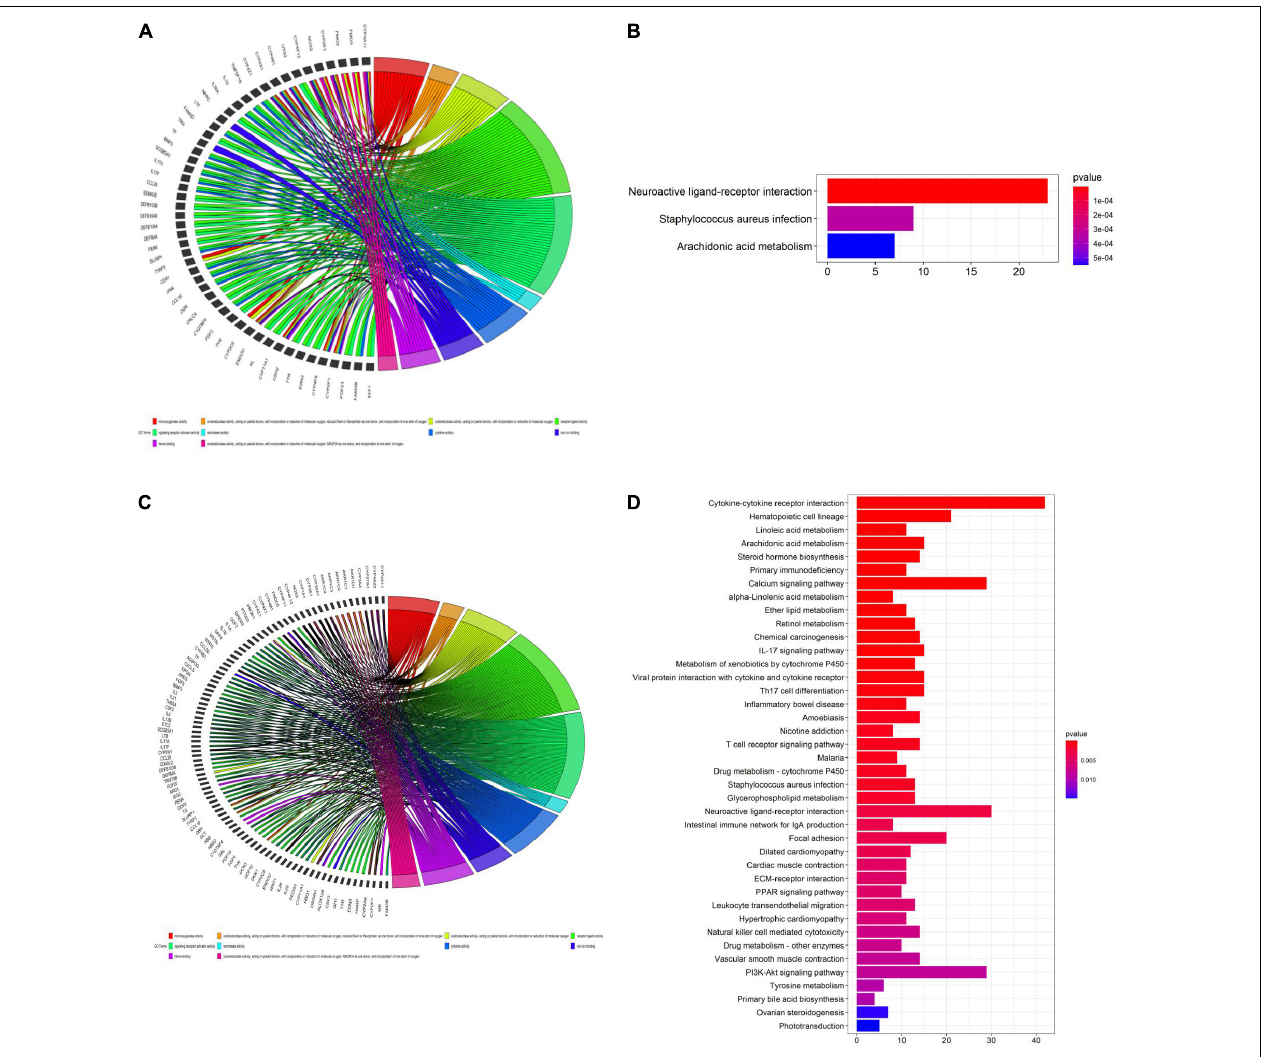
FIGURE 8 | Gene ontology (GO) (A,C) and Kyoto encyclopedia of genes and genomes (KEGG) (B,D) enrichment analyses. (A,C) GO enrichment analysis of the cancer genome atlas (TCGA) training set. (B) KEGG enrichment analysis of the TCGA training set. (C) GO enrichment analysis of the TCGA validation set. (D) KEGG enrichment analysis of the TCGA validation